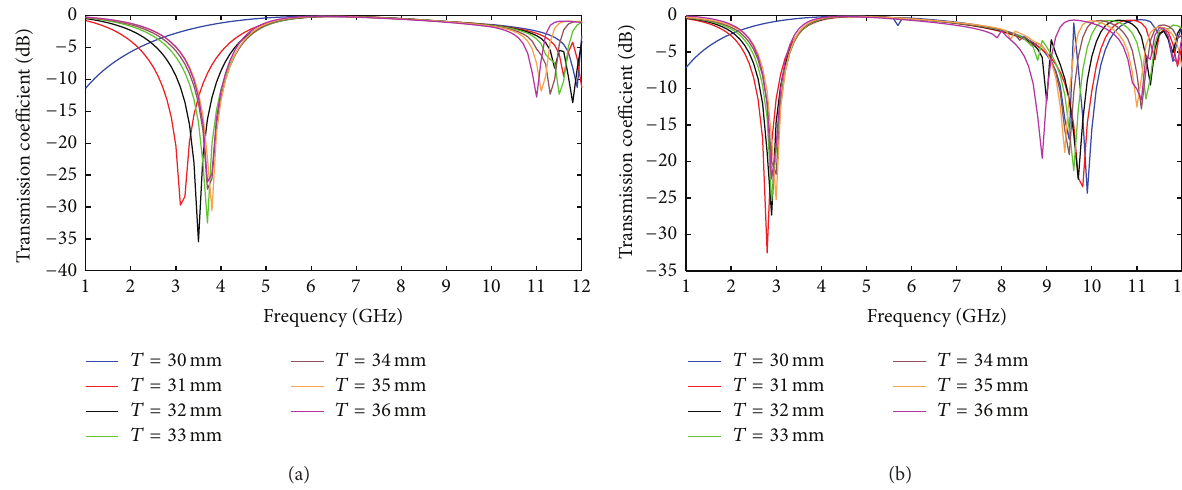
Figure 4: Simulation results for the transmission coefficient for different FSS array periodicity values: (a) FSS 1 (generator) and (b) FSS 2 (first fractal iteration).